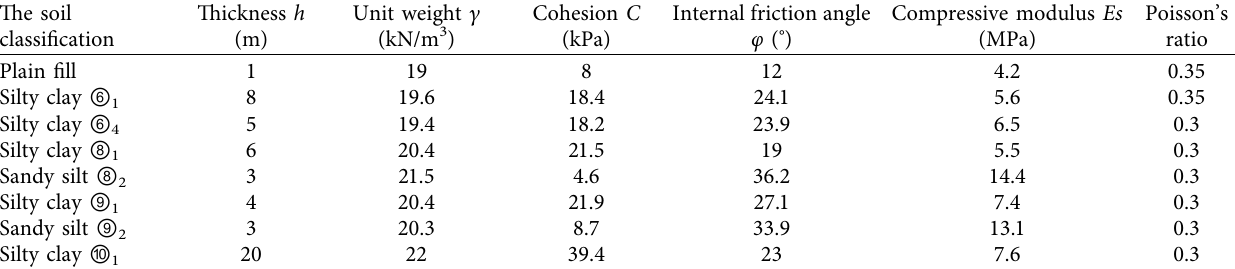
Table 1: Soil mechanics parameters.